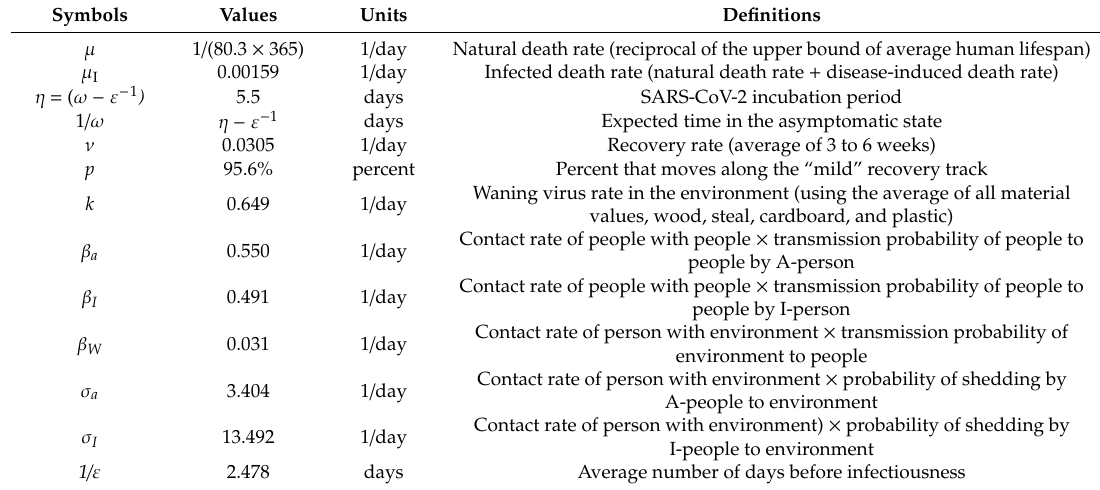
Table 2. Definitions for the nominal parameter values used in this study: parameter values were developed from empirical findings and country-level data, as discussed in another study